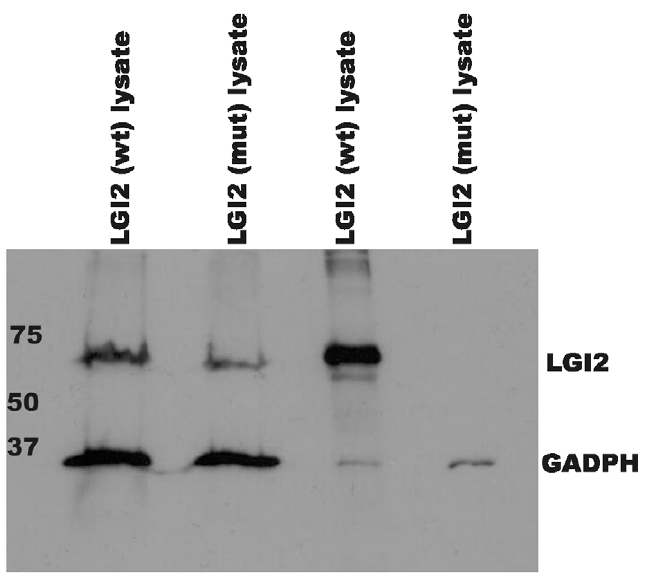
Figure 3. Mutant LGI2 is not secreted in cell cultures. HEK293 cells were transfected with human V5-tagged wt and p.K534X mutant LGI2 clones. Aliquots of lysed cells (lanes 1&2) and culture media (lanes 3&4) were harvested, concentrated, and analyzed with anti-V5 and anti-GADPH antibodies to follow expression of the recombinants. Only wild-type LGI2 protein is found in culture media indicating that the K534X mutation prevents secretion.